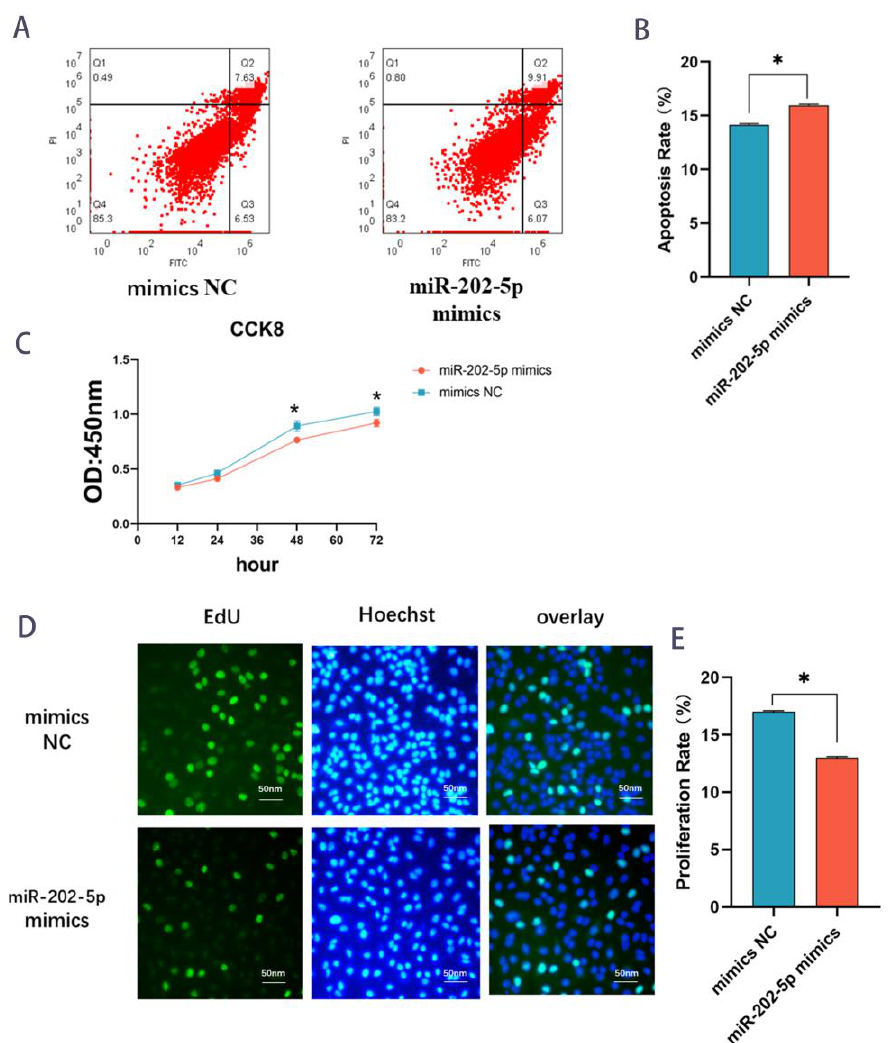
Figure 6. miR-202-5p induces the apoptosis of follicular GCs. ( A , B ) Flow cytometric results of miR-202-5p mimics vs. mimics NC. Flow cytometric results histogram of miR-202-5p mimics vs. mimics NC. (Mean results ± SD, * p < 0.05 indicates significant difference) ( C ) CCK8 line graph of miR-202-5p mimics and mimics NC. OD values at 450 nm were determined at 12 h, 24 h, 48 h, and 72 h. (Mean ± SD, * p < 0.05). ( D , E ) EdU cell proliferation assay. Comparison of miR-202-5p mimics as well as mimics NC in EdU fuel (proliferating cells) as a percentage (%) of hoechst fuel (overall cells). Three replicates per group, mean ± SD, * p < 0.05 indicates a significant difference.